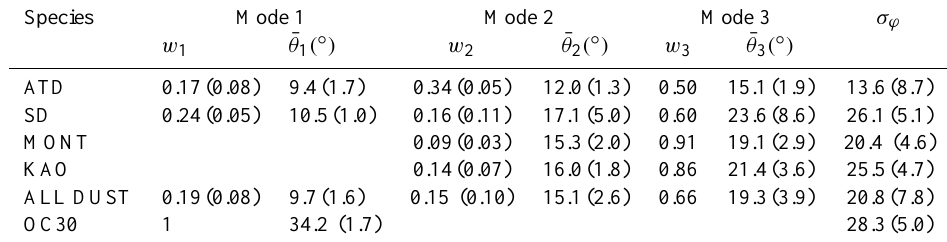
Table 3. Summary of average parameters (standard deviation) for the nucleation spectra of Table